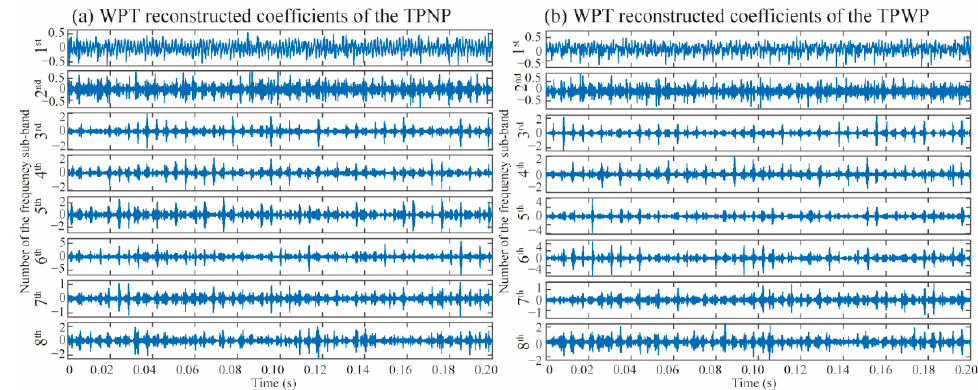
Figure 5. WPT-reconstructed coefficients. ( a ) TPNP; ( b ) TPWP.